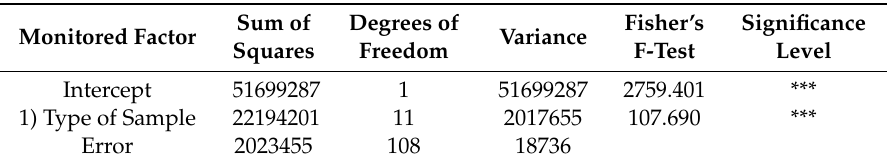
Table 17. Statistical evaluation of the e ff ect of the factors and their interaction on the minimum bend radius at the yield point ( R minB ) for beech and NWC on the bottom.